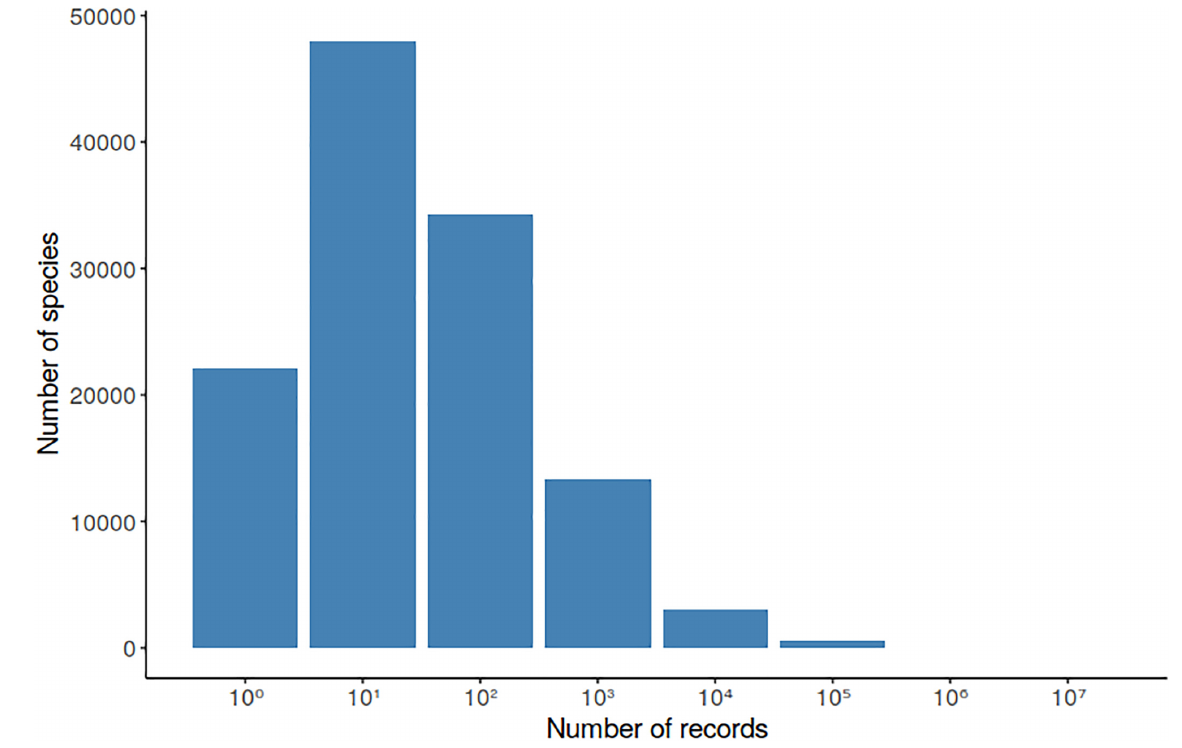
Frontiers in Marine Science |